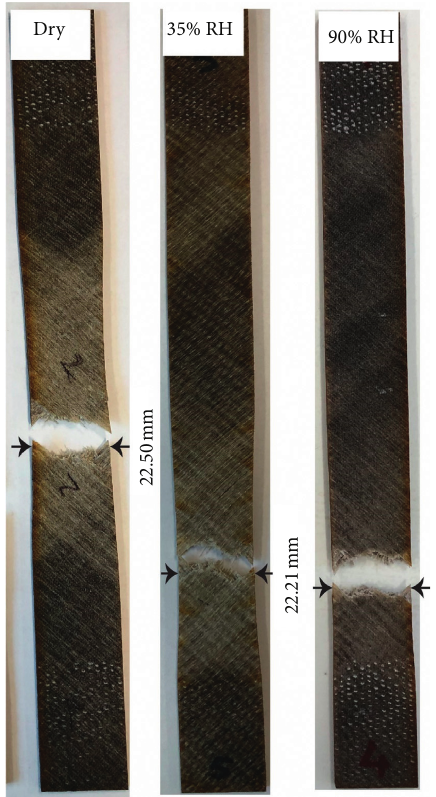
Figure 5: In-plane shear failure during tensile tests of ± 45 ° aligned flax/epoxy composite